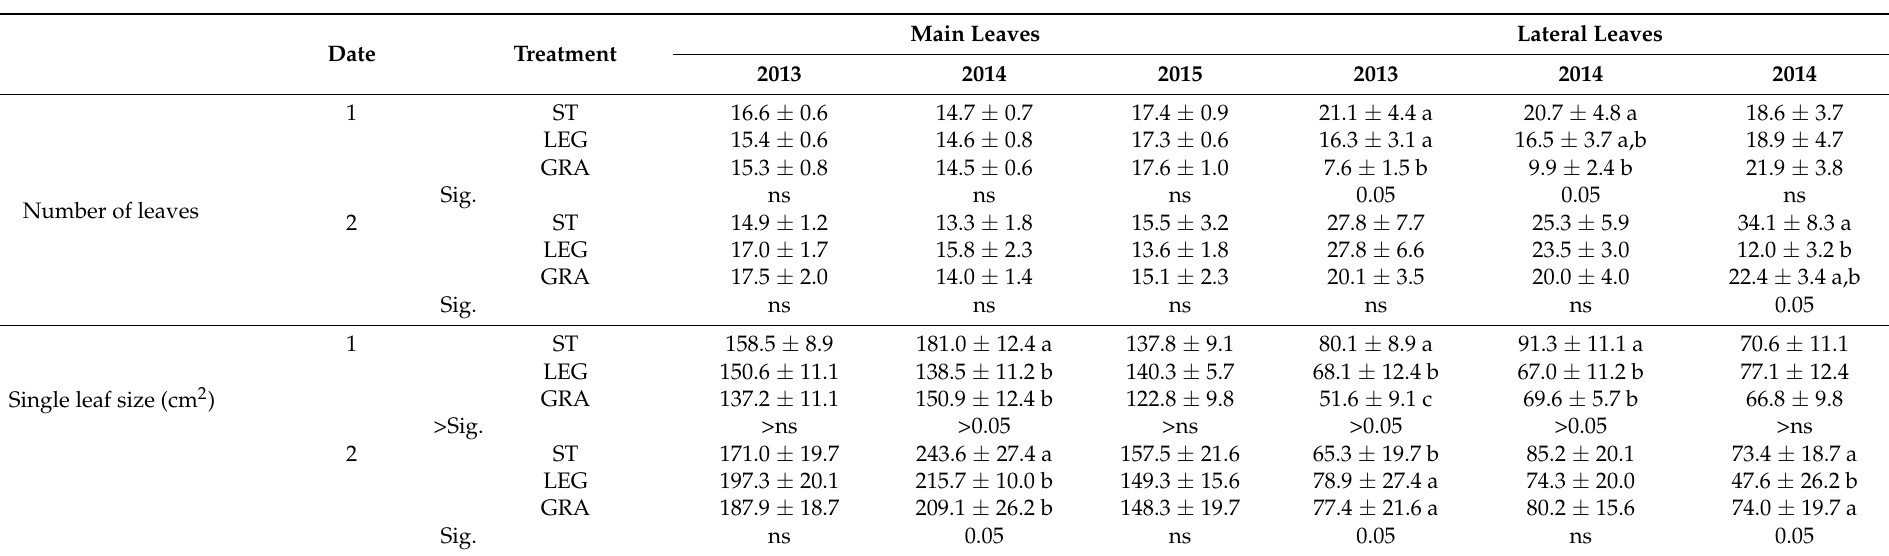
Table A1. Number of main and lateral leaves and single leaf size of the main and lateral per shoot at dates 1 and 2 of the LA measurements. Values are the mean ± standard error and different letters indicate significant differences among treatments at p < 0.05, ns—not significant.